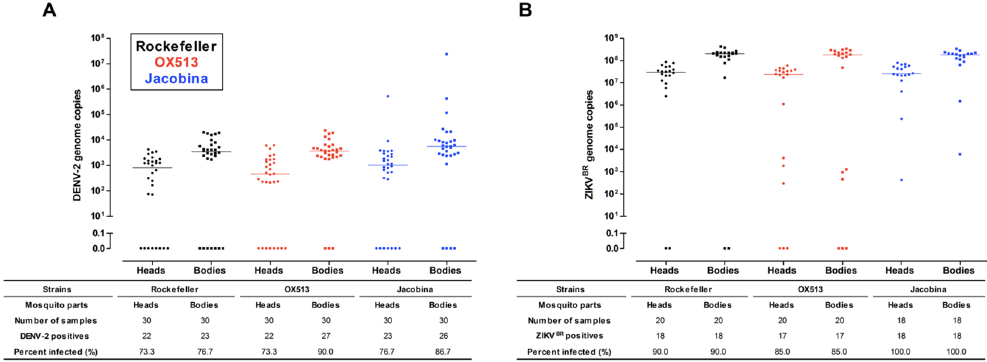
Figure 3. Levels of DENV-2 (left) and ZIKV (right) genomic copies detected in heads and bodies without heads of Rockefeller, OX513 and Jacobina mosquitoes challenged via oral infection. None of the strains differ by Kruskal Wallis tests followed by Dunn’s post-test (p > 0.05). Experimental details in Supplementary